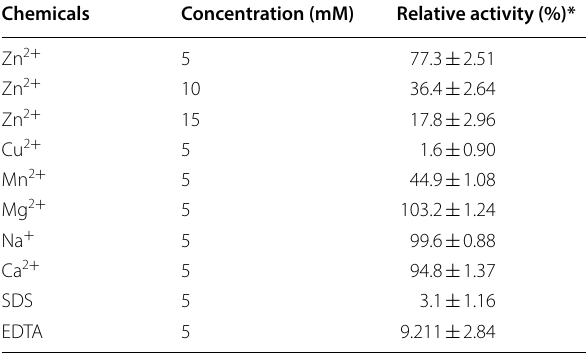
* Values represent mean